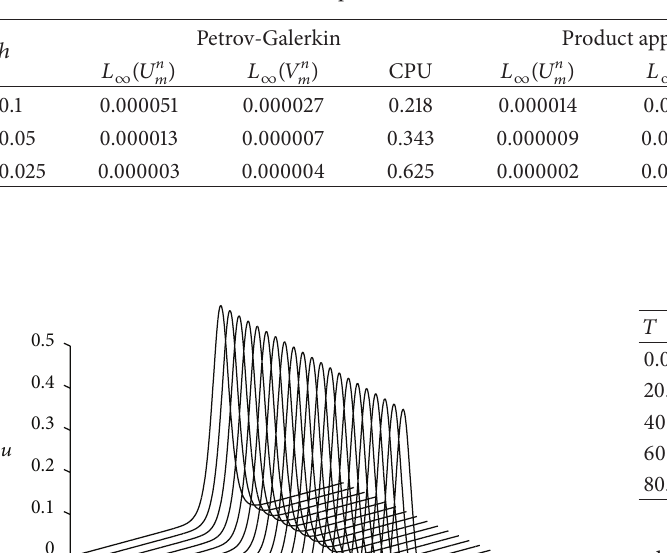
Table 3: Comparison of three methods with 𝑎 = 0.5 , 𝑏 = −3.0 , 𝜆 = 0.5 , 𝑘 = 0.01 , and 𝑡 = 1 .